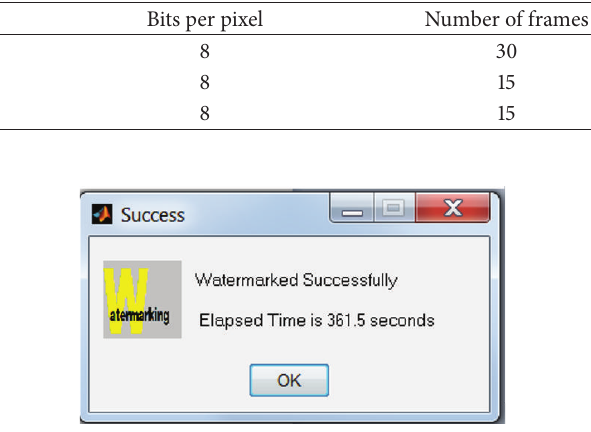
Table 4: Ultrasound medical images samples properties.